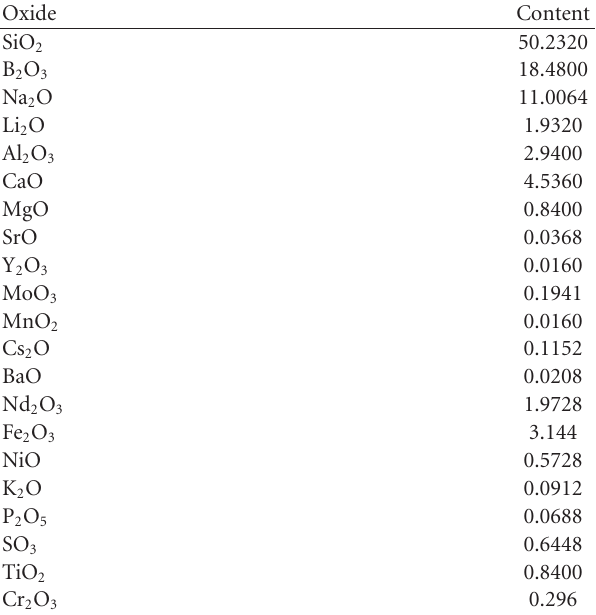
Table 1: The Composition of the simulated HLW (wt% mass of the oxides).